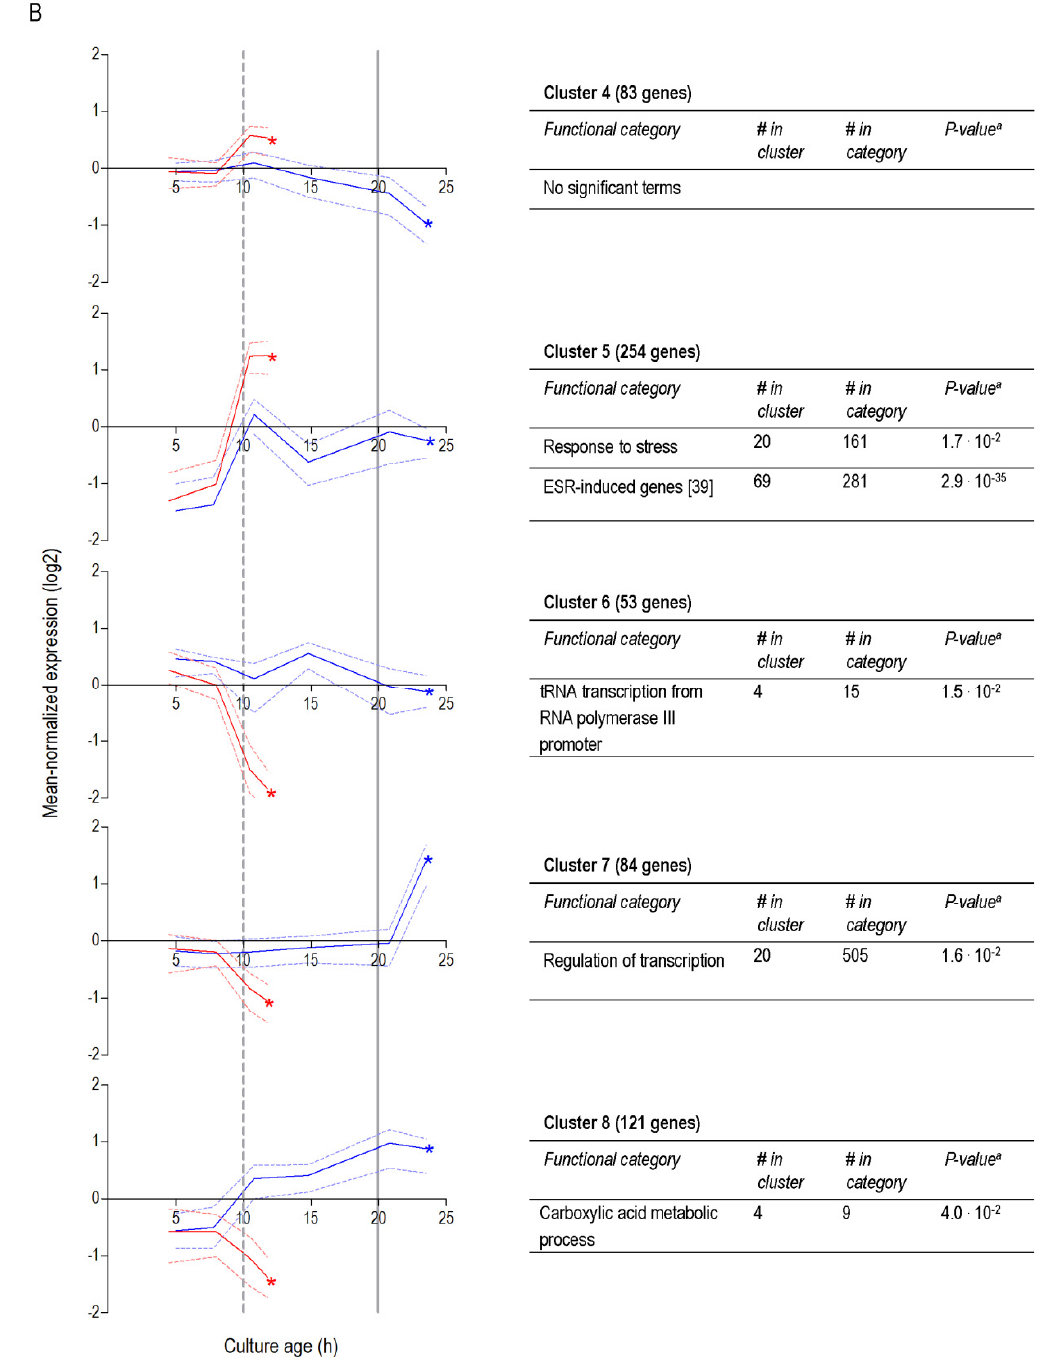
FIGURE 6: Clustering of genes differentially expressed between aerobic and anaerobic SP cultures according to their expression profiles during the growth phases preceding SP. Genes whose differential expression between aerobic and anaerobic SP cultures originated from changes after glucose depletion (A) . Clusters of genes whose differential expression between aerobic and anaerobic stationary phase cultures from changes upon glucose exhaustion (B). Each graph presents the expression profiles of genes from aerobic culture ( blue lines ) and anaerobic cultures ( red lines ) in a particular gene cluster. The solid lines represent the average of the mean-normalized expression of all genes in the cluster. The dashed lines represent the first and third quartile of these mean-normalized expression values, giving information on the scatter in the expression of genes in the cluster. Asterisks (*) indicate the SP samples from anaerobic and aerobic batches. Vertical lines indicate glucose exhaustion ( dashed line ) and carbon exhaustion ( solid line , for aerobic cultures only). For each cluster a table reports the overrepresentation of functional categories, including the number of genes in the cluster belonging to a specific functional category (# in cluster), the total number of genes in this functional category (# in category), and the a Bonferroni-corrected P-values that indicate the likelihood of obtaining such enrichment in a random set of genes. Only categories with a Bonferroni-corrected P-value below 0.05 were deemed significant and presented in the tables. More details can be found in Supplemental Table